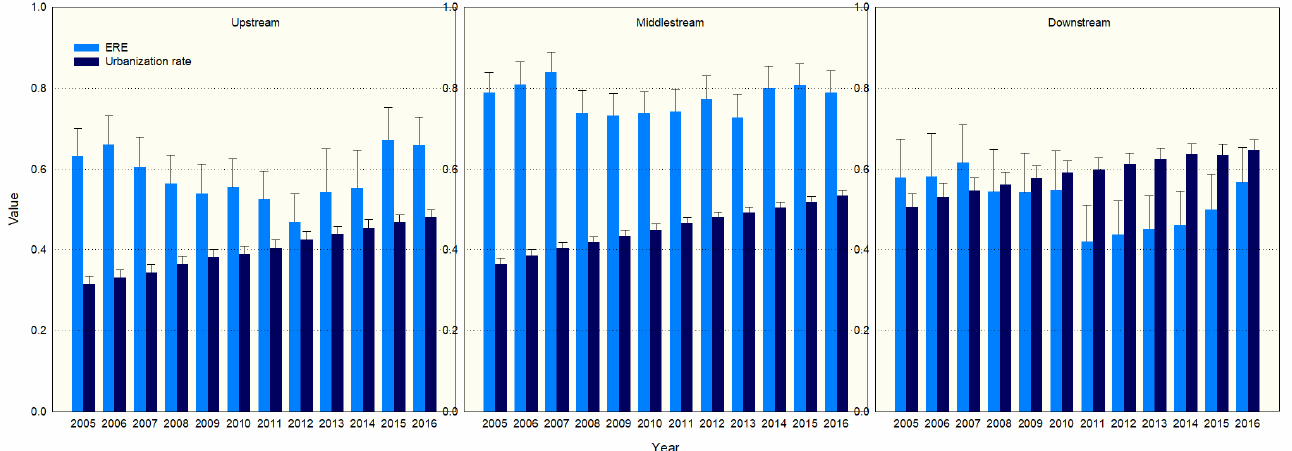
Figure 4. Regional ERE and urbanization rate grouped bar charts with error bars.